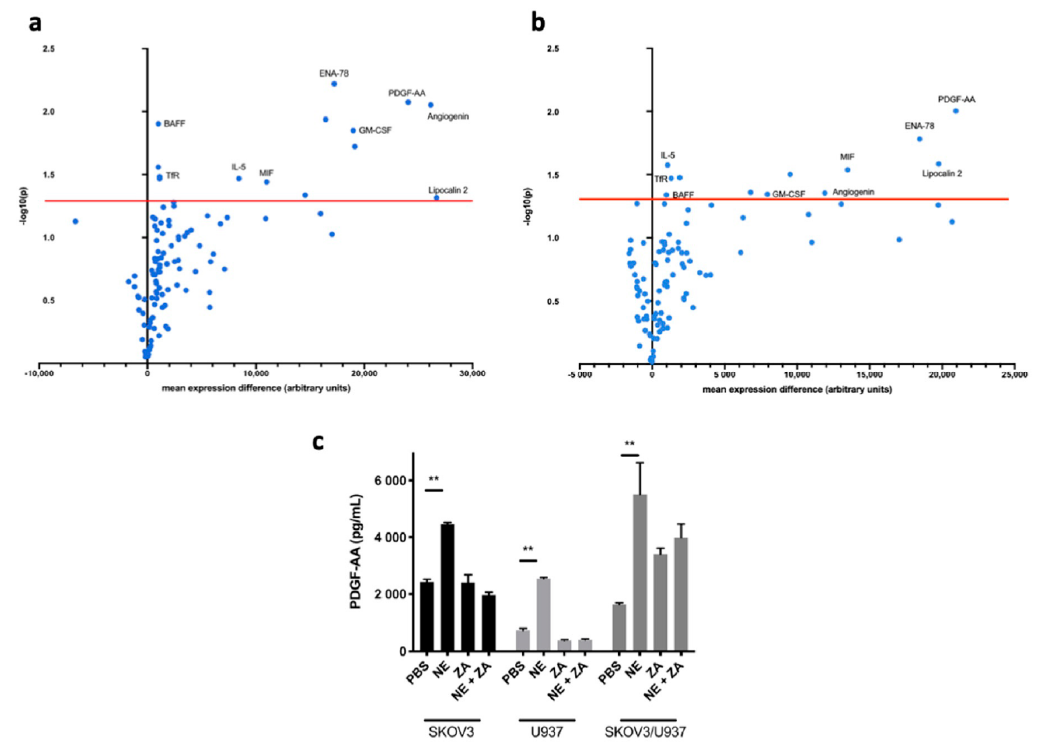
Figure 2. Cytokine profile of adrenergic stimulated ovarian cancer cells/macrophage co-cultures ( a ) Volcano plots showing cytokine changes of SKOV3ip1and U937 co-cultures 24 hrs after Epi or ( b ) NE treatment. The Y-axis depicts the two-class comparison’s statistical significance in –log notation of the t -test’s p -value. Thus, the higher the dot, the higher the statistical significance. The X-axis depicts the expression compared to monoculture conditions. The farther to the right, the higher the expression. The red line marks the threshold for statistical significance established at p < 0.05. Cytokines labeled are shared between Epi and NE groups. ( c ) Zoledronic acid (ZA) prevents NE-induced platelet-derived growth factor AA (PDGF-AA) release in SKOV3 and U937 monocultures and SKOV3/U937 co-cultures. Mean ± SEM. ** p < 0.01.